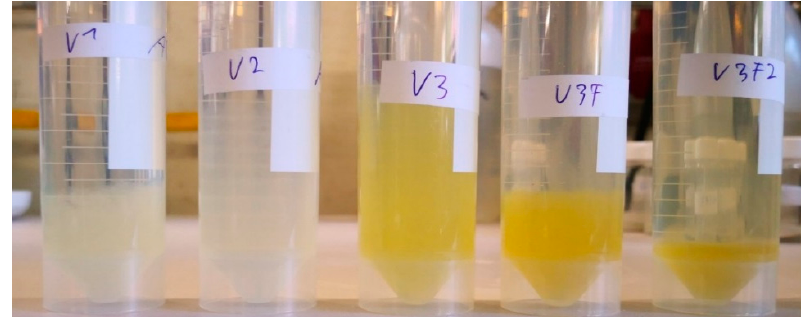
Figure 8. Precipitated solid residues from water solution after carbonation at 175 °C, 120 bar, s/L 1:10 (V1-600 rpm, 120 min; V2-600 rpm, 240 min; V3-1800 rpm, 120 min; V3F-1800 rpm, 40 min; V3F2-1800 rpm, 2 min).